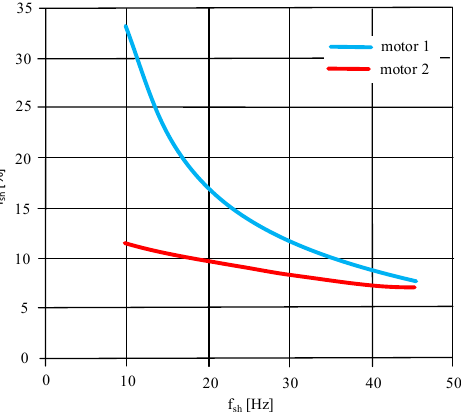
Figure 5. Current subharmonics vs. the subharmonic frequency for motor 1 and motor 2.